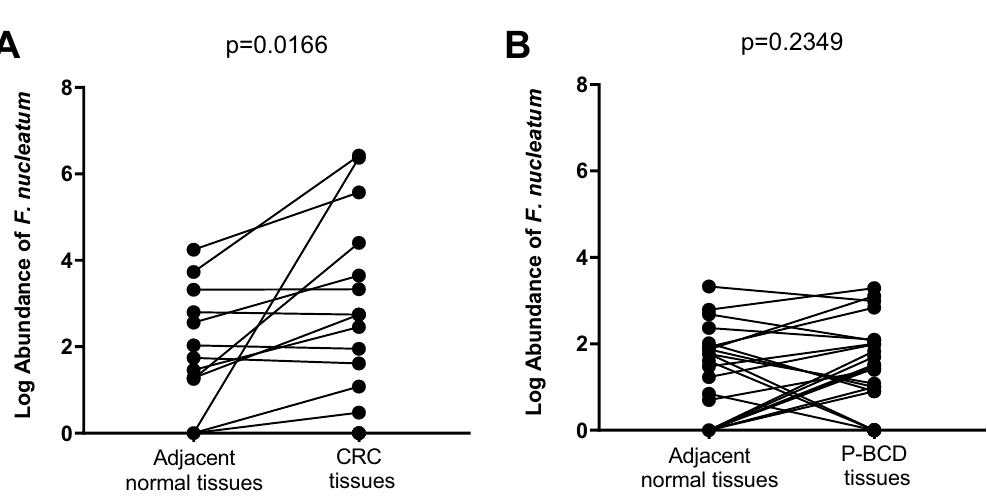
Figure 1. Log abundance of F. nucleatum DNA in tissues (15 CRC and 26 P-BCD patients). (A) CRC patients (B) P-BCD